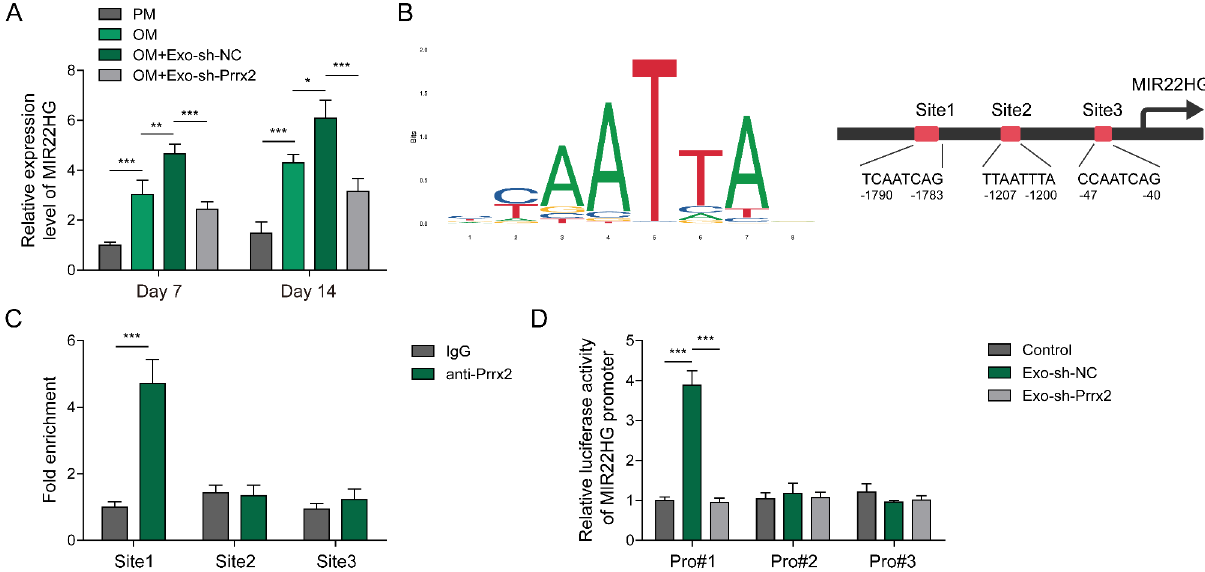
Fig. 3 Myoblast-derived exosomal Prrx-2 increases transcriptional activity of lncRNA-MIR22HG in BMSCs. (A) qRT-PCR analysis of MIR22HG expression in BMSCs from the PM, OM, OM + Exo-shNC, OM + Exo-shPrrx-2 groups. (B) JASPAR database analysis of the binding sites of Prrx-2 in MIR22HG promoter. (C) ChIP and (D) Dual-luciferase reporter assays were adopted to validate the direct binding of Prrx-2 in MIR22HG promoter. * P < 0.05, ** P < 0.01 and *** P <